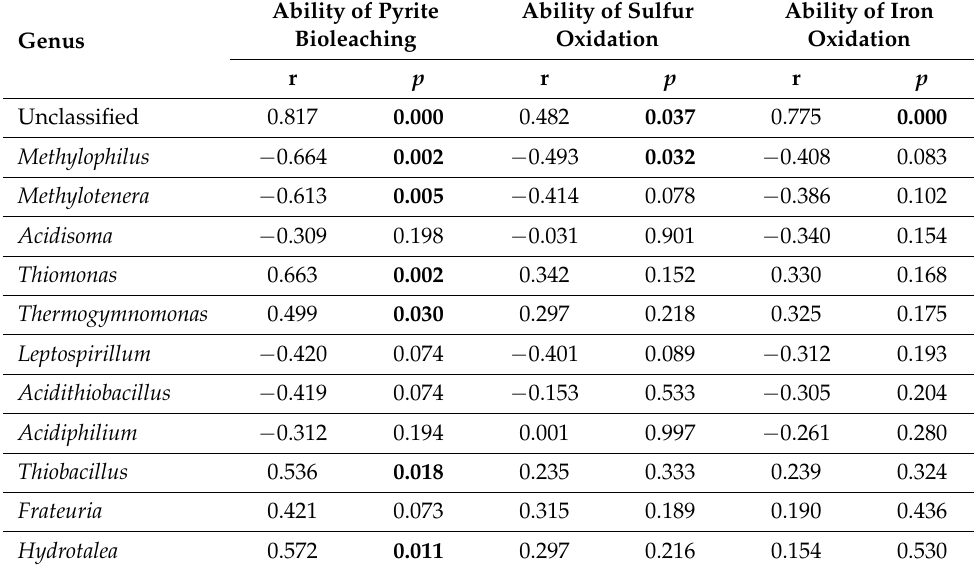
Table 4. Summary of relationships between the dominant genera and functions by Pearson correlation tests [25] (open access). Significant differences are indicated in bold. Ability of Pyrite Ability of Sulfur Ability of Iron Bioleaching Oxidation Oxidation Genus r p r p r p Unclassified 0.817